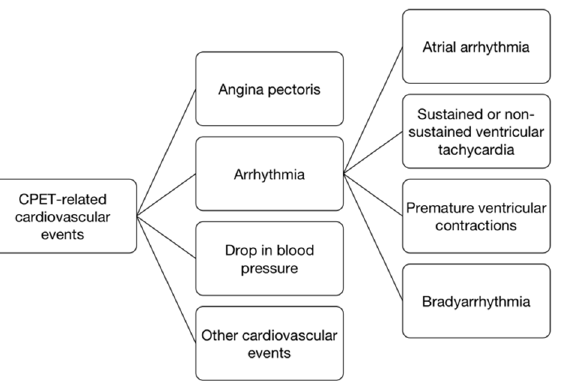
Figure 1. Tree diagram summarizing CPET-related cardiovascular events. CPET, cardiopulmonary exercise testing .